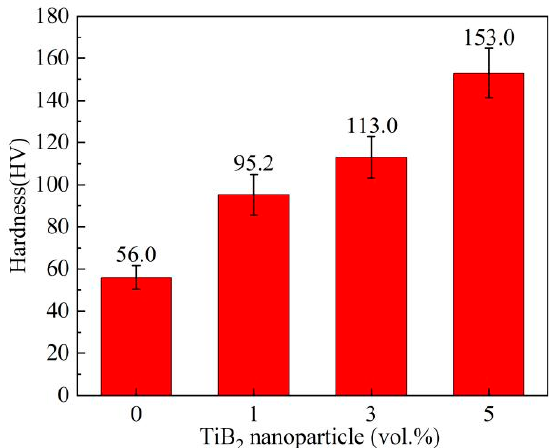
Figure 8. Variation of Vickers hardness with vol.% of TiB 2 nanoparticles.